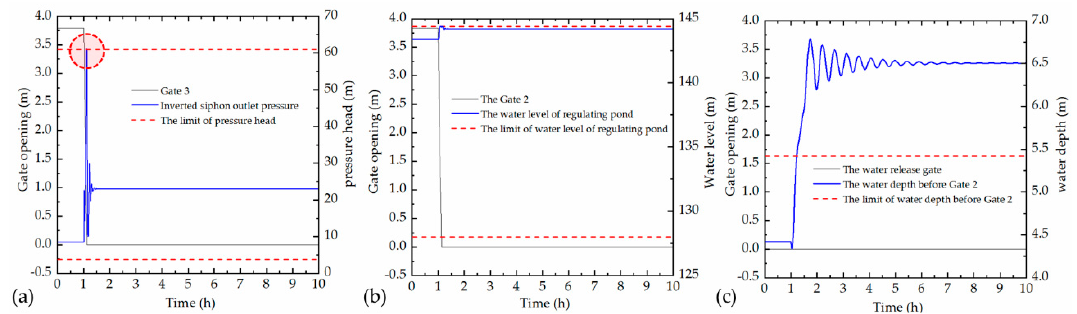
Figure 12. The simulation result of Scenario D-2 without MPC-1 and MPC-2: ( a – c ) are same with Figure